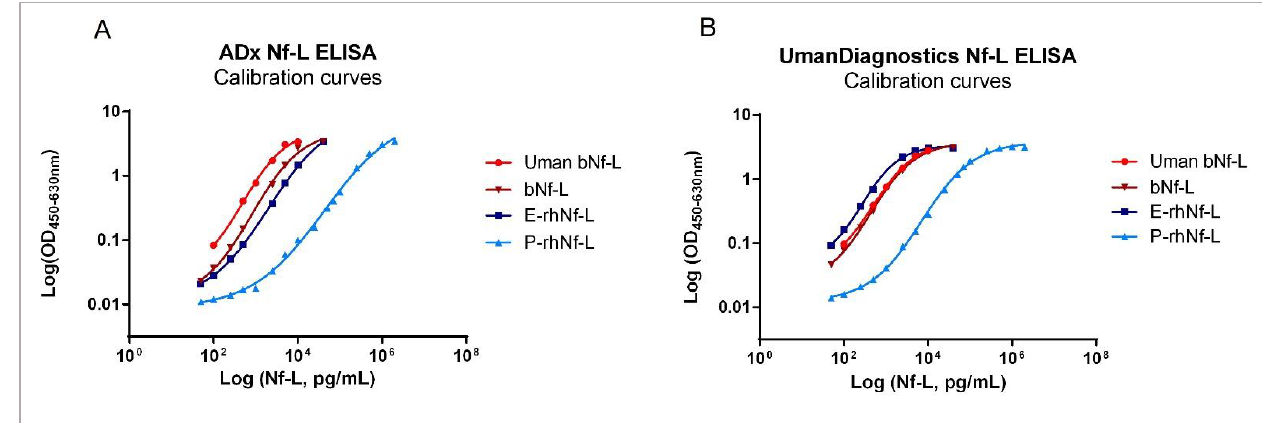
Table 6. Comparison of primary calibrators by ADx Nf-L ELISA and UmanDiagnostics Nf-L ELISA in 14 unclassified CSF samples. Figure 9. Evaluation of the primary calibrators by the ADx NeuroSciences Nf-L ELISA and the UmanDiagnostics Nf-L ELISA. Calibration curves of the three primary calibrators as well as the UmanDiagnostics standard bNf-L calibrator measured in ( A ) the ADx Nf-L ELISA and ( B ) the Undiagnostic Nf-L ELISA.